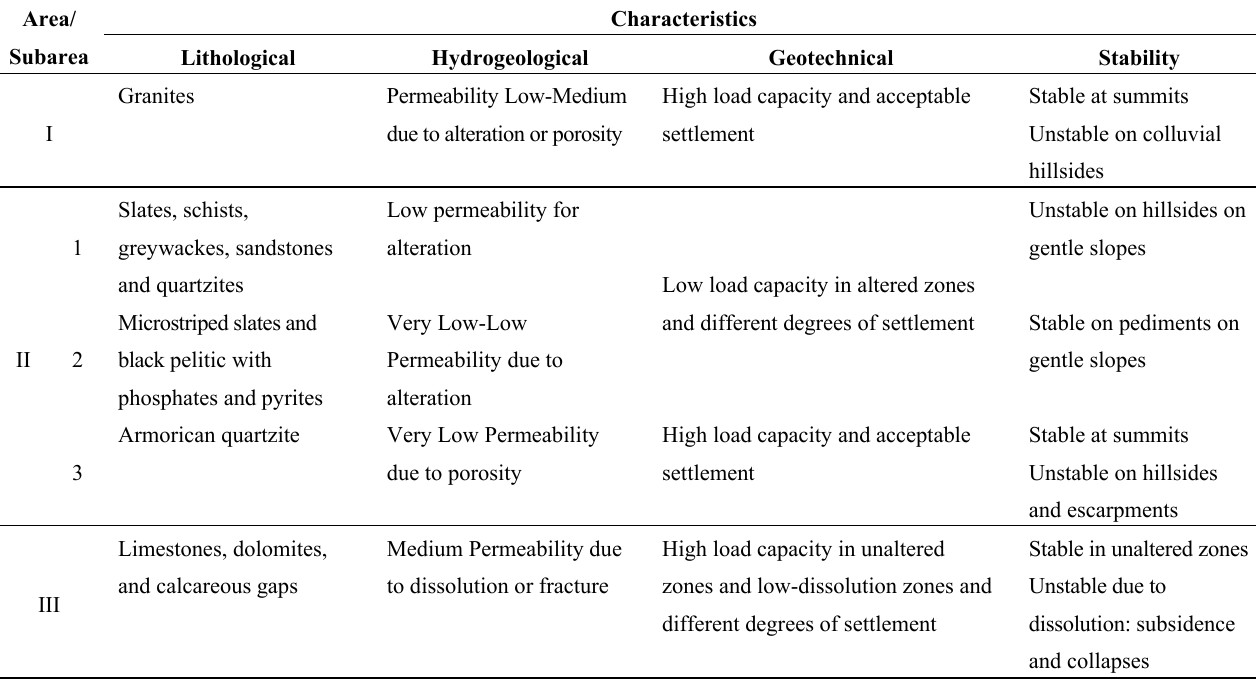
Table 1. Area and subarea with the lithological, hydrogeological, geotechnical and stability